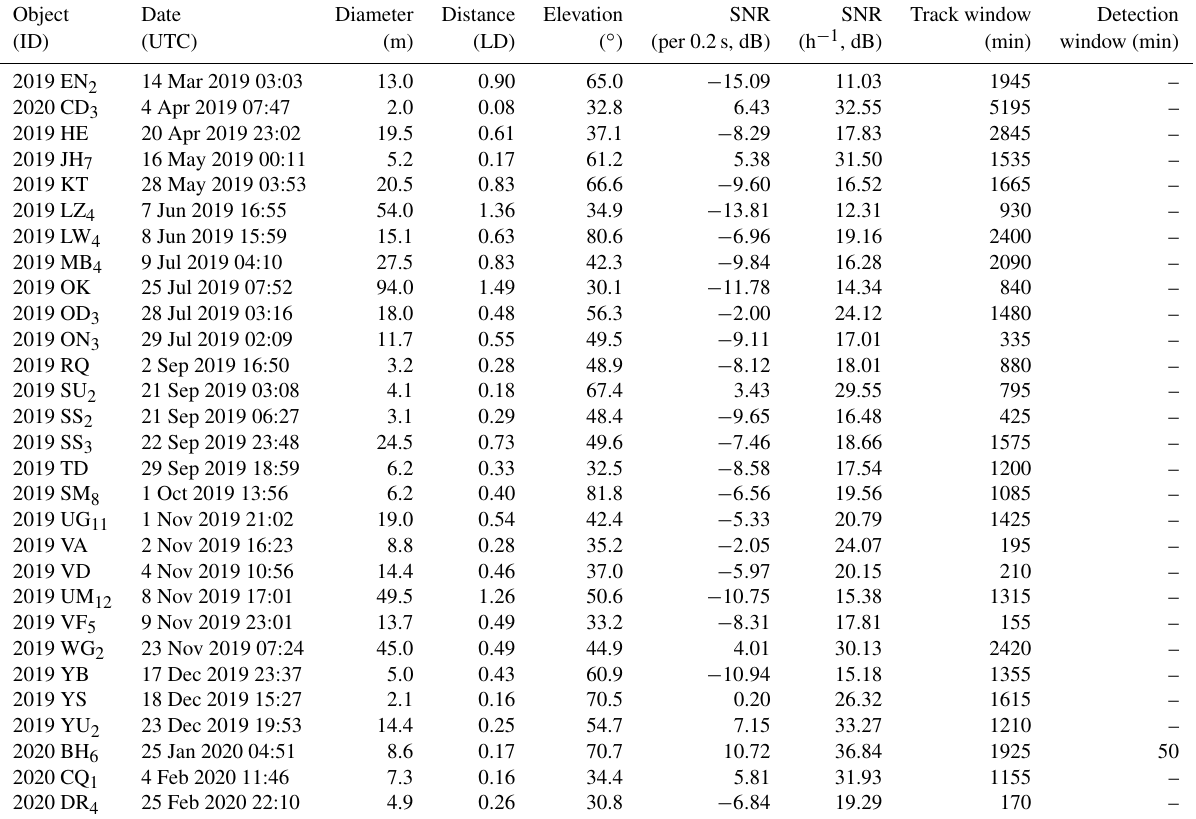
Table 1. Objects detectable using E3D during a 1year